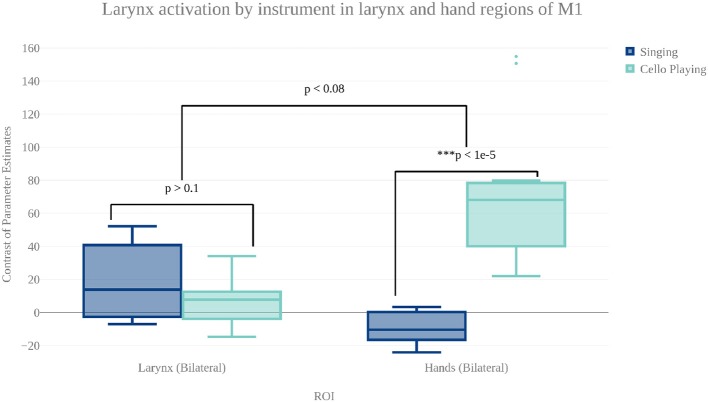
Contrast of parameter estimates (units arbitrary) in larynx and hand area of motor cortex for singing (blue) and cello playing (turquoise). The anova showed no significant effect of instrument or brain area, but did show a significant instrument by region interaction.